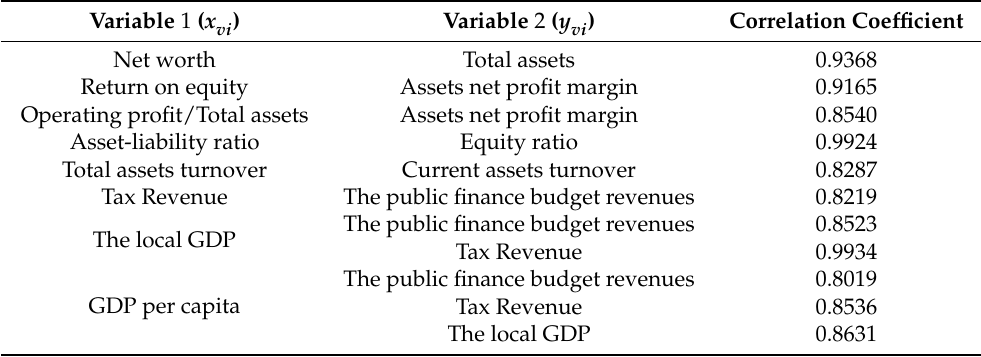
Table 2. Characteristic variables correlation